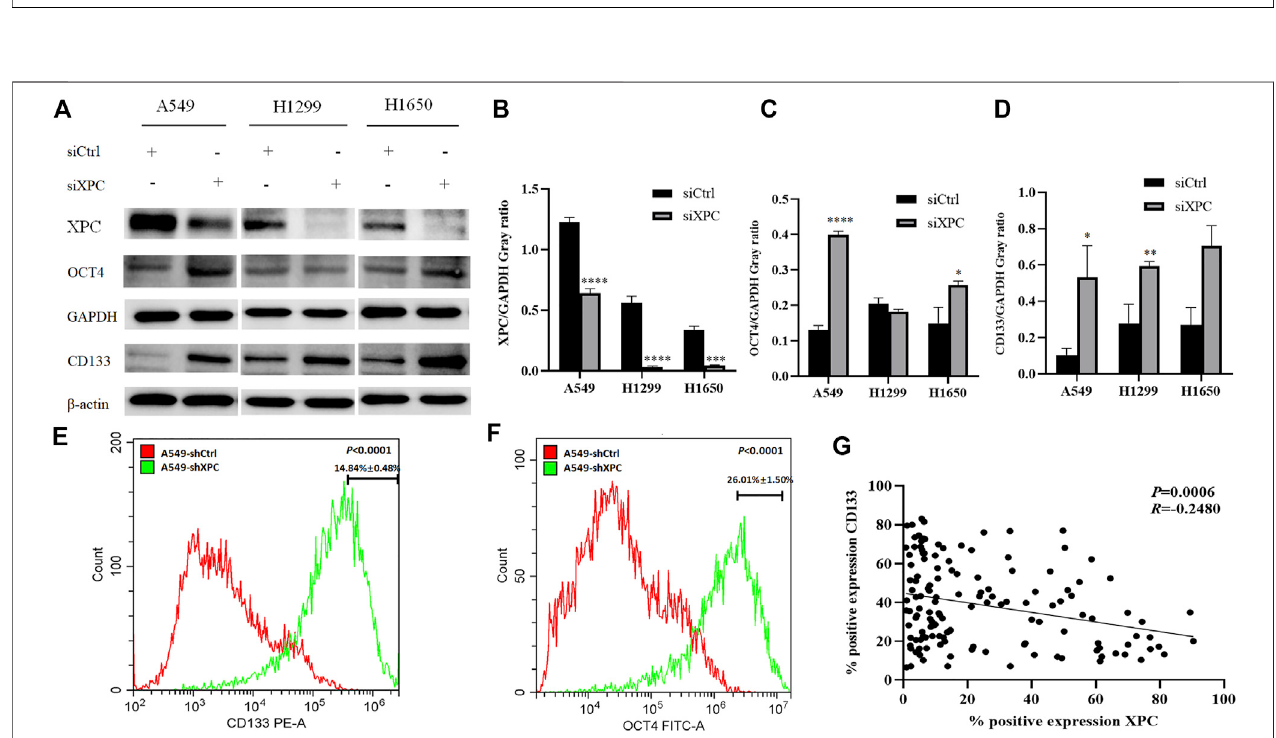
FIGURE5| TheeffectofXPCexpressiononstemcellmarkers. (A) .The3 celllinesA549,H1299,andH1650weredividedintotwogroups:siCtrlgroupandsiXPC group. Western blot was used to detect the expression of stem cell markers in the siCtrl group and siXPC group. (B) . In the 3 cell lines A549, H1299, and H1650, the expression of XPC in the siXPC group was lower than that in the siCtrl group ( **p < 0.01, ***p < 0.001, ****p < 0.0001). (C) . In the A549 and H1650 cell lines, the expression of OCT4 in the siXPC group was higher than that in the siCtrol group ( *p < 0.05, ****p < 0.0001). (D) . In the 3 cell lines A549, H1299, and H1650, the expression of CD133 in the siXPC group was higher than that in the siCtrl group ( *p < 0.05, **p < 0.01). (E,F) . The protein levels of CD133 and OCT4 were determined using Flow Cytometry. p < 0.0001(CD133), p < 0.0001(OCT4), A549-shXPC compared with A549-shCtrl. (G) . Immunohistochemical detection of XPC and CD133 expression correlation in 140 cases of lung adenocarcinoma tissues ( p < 0.0006, R (cid:1) − 0.2580).